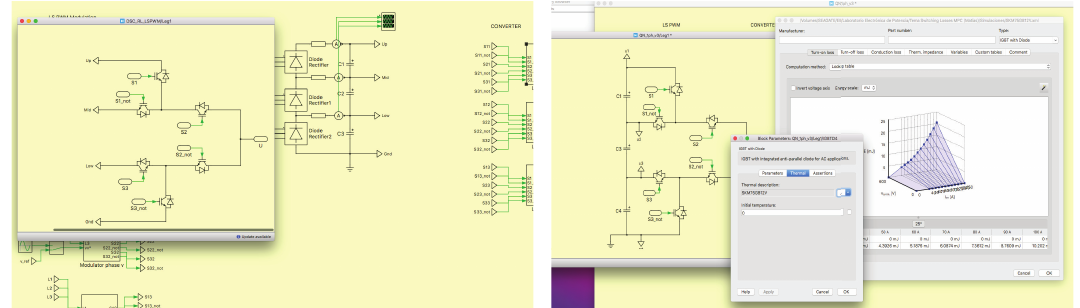
Figure 10. HIL quasi-nested implementation and IGBT